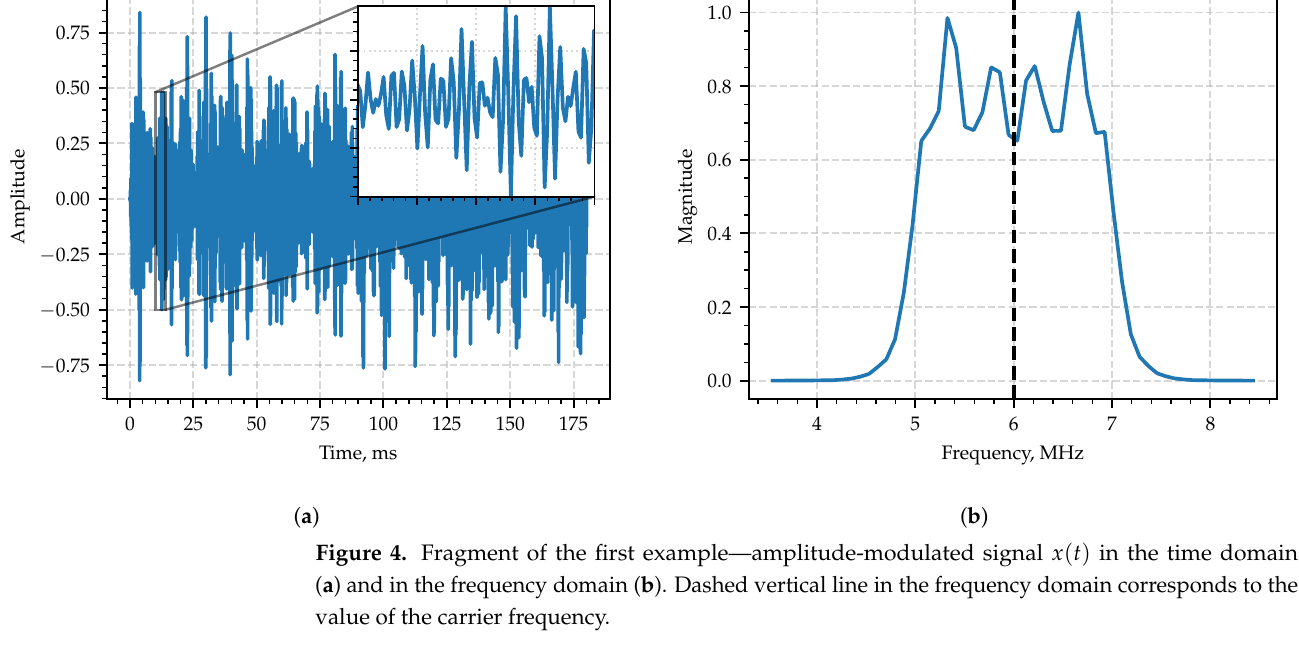
Figure 4. Fragment of the first example—amplitude-modulated signal x ( t ) in the time domain ( a ) and in the frequency domain ( b ). Dashed vertical line in the frequency domain corresponds to the value of the carrier